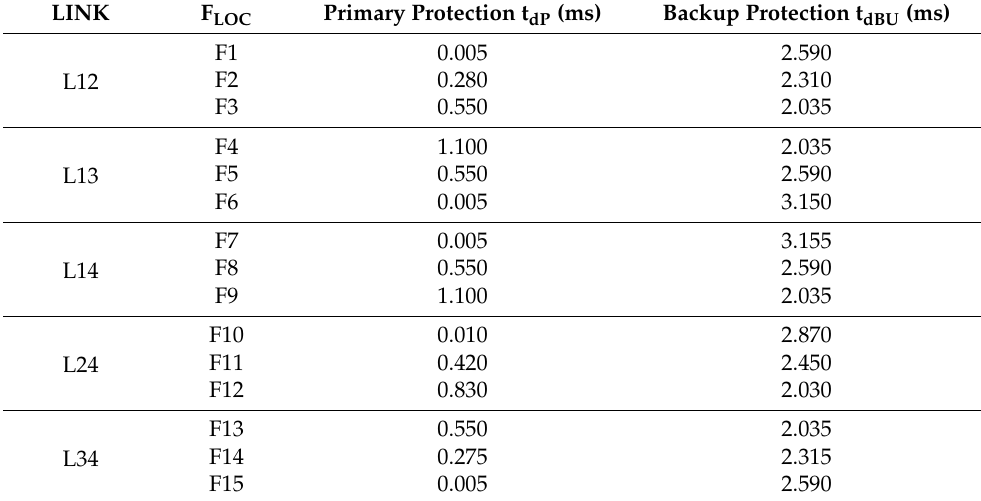
Table 4. Fault detection time in milliseconds for the proposed protection system against different 0 Ω PtP fault